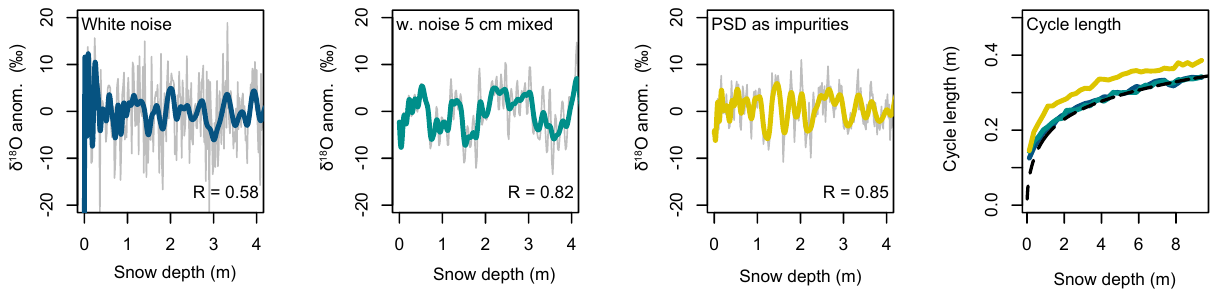
Figure A1. Sensitivity of the cycle length to the temporal correlation structure of the assumed input signal. Thin lines show the undiffused signal, while thick coloured lines the signal after diffusion. The correlation between the undiffused and the diffused signals is provided in the panels. For the more structured signals (mixed white noise and variability mimicking impurities), a larger fraction of the signal is preserved, leading to higher correlations. The resulting cycle length (right panel, coloured lines) is only weakly dependent on the input signal and is close to the theoretical result for white noise (Rice’s formula, dashed line).